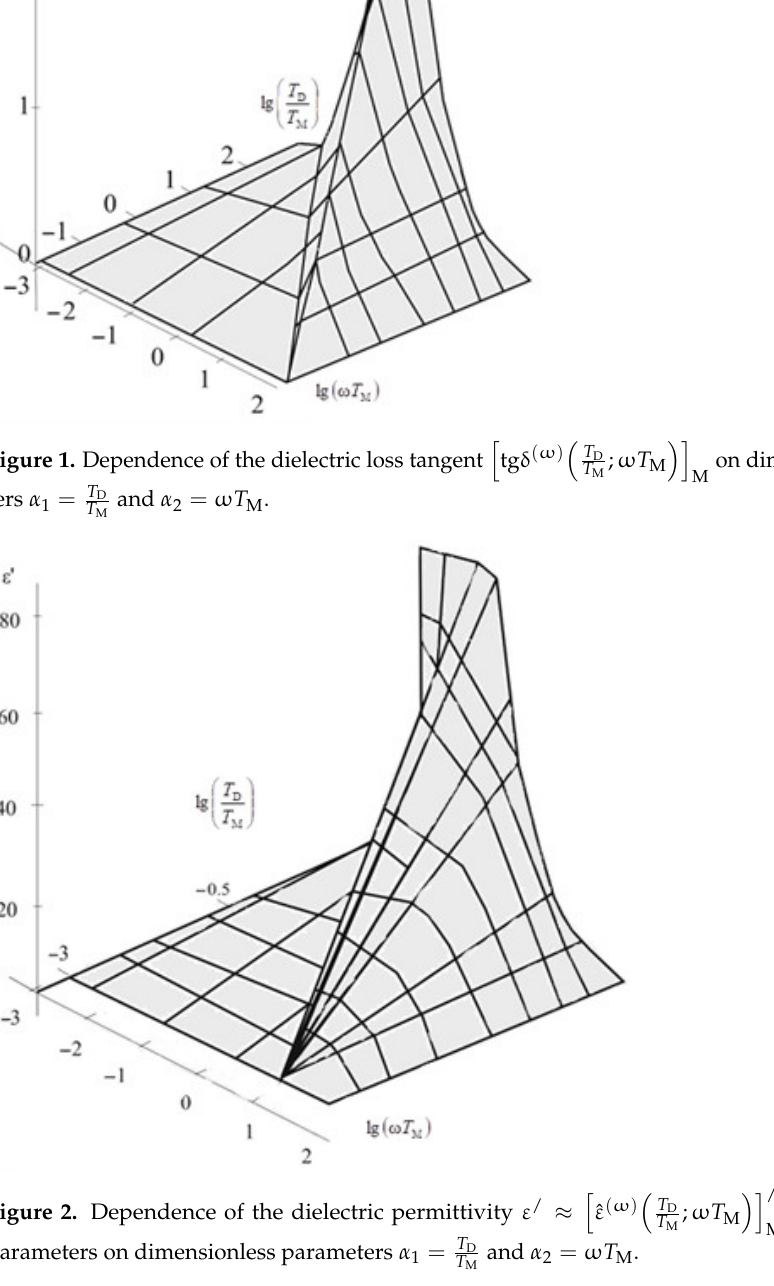
Figure 2. Dependence of the dielectric permittivity ε / ≈ on dimensionless parameters α 1 = T D